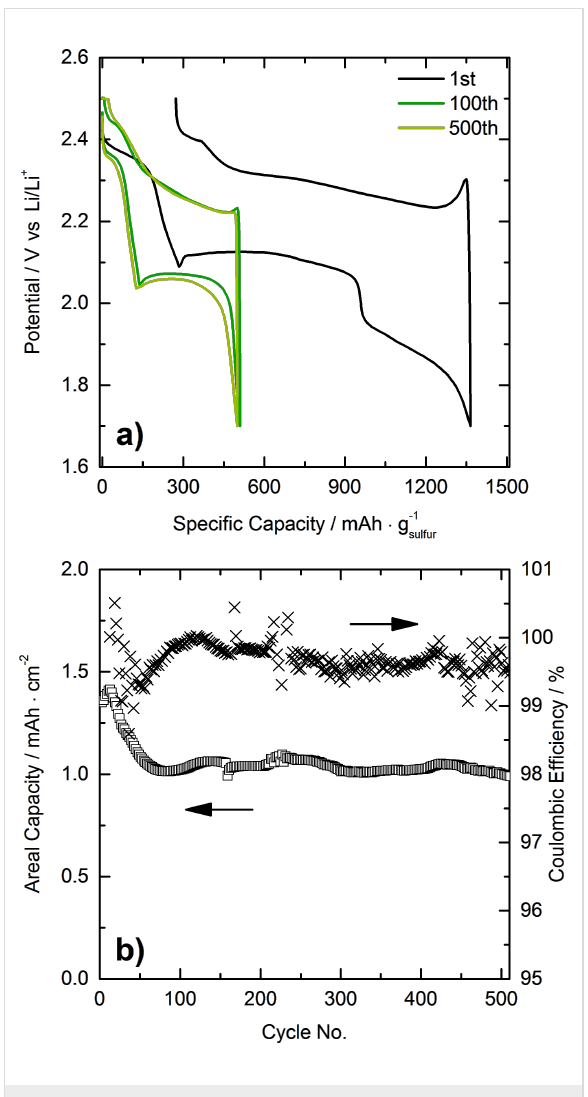
Figure 8: a) Voltage profiles of a Li–S cell with areal sulfur loading of 2.0 mg·cm − 2 . After the formation cycle at C/50, the rate was increased to C/5. b) Areal capacity and Coulombic efficiency versus the cycle number. The 1st cycle areal capacity was about 2.8 mAh·cm − 2